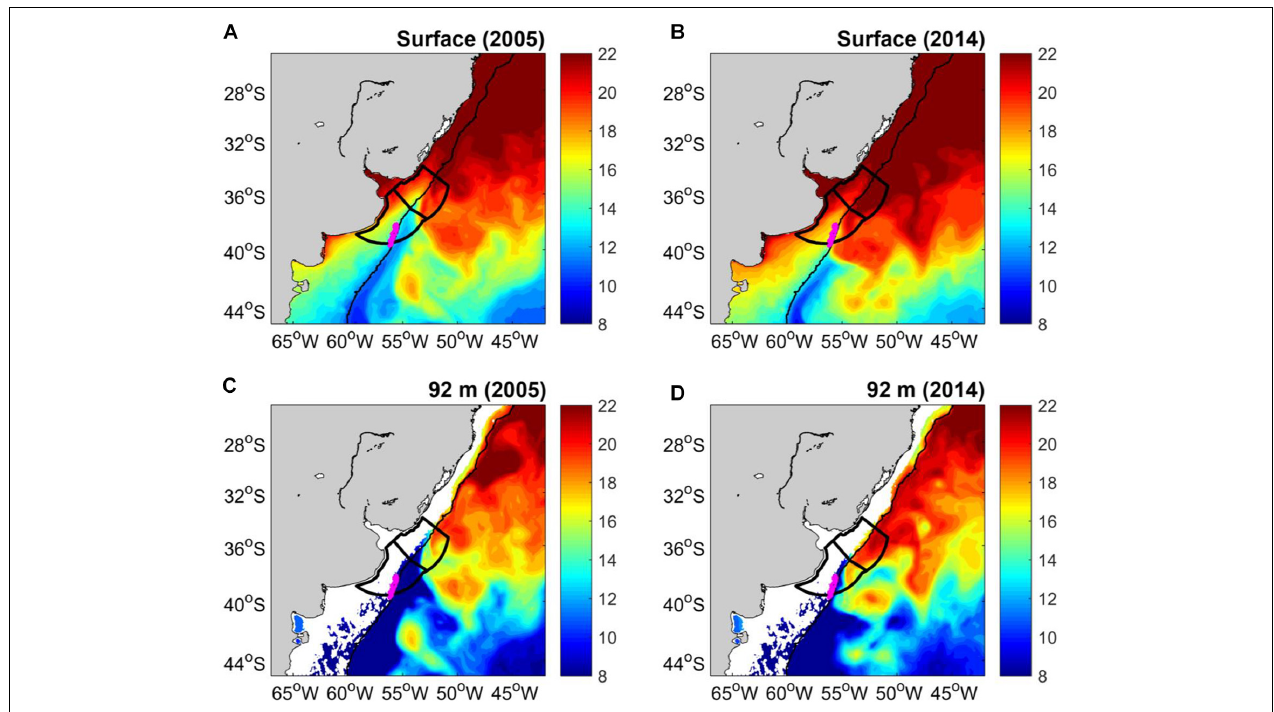
FIGURE 7 | GLORYS12 mean temperature at surface during (A) 2005 and (B) 2014. GLORYS12 mean temperature at 92 m depth during (C) 2005 and (D) 2014. The Argentina-Uruguay Common Fishing Zone (AUCFZ) is shown by two polygons with black heavy lines. The northernmost and largest Patagonian scallop bed is shown by a magenta polygon. The 200 m isobath is